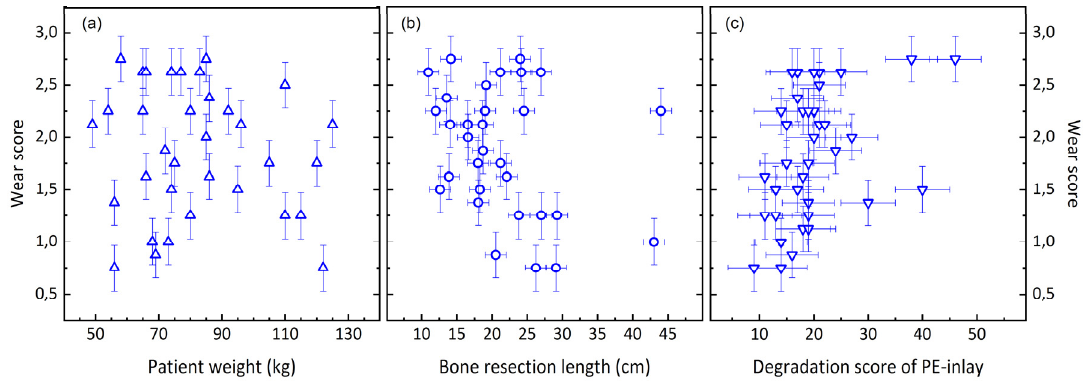
Figure 7. Scatter plots of wear score over ( a ) patient weight, ( b ) bone resection length and ( c ) degradation score of the polyethylene inlays.